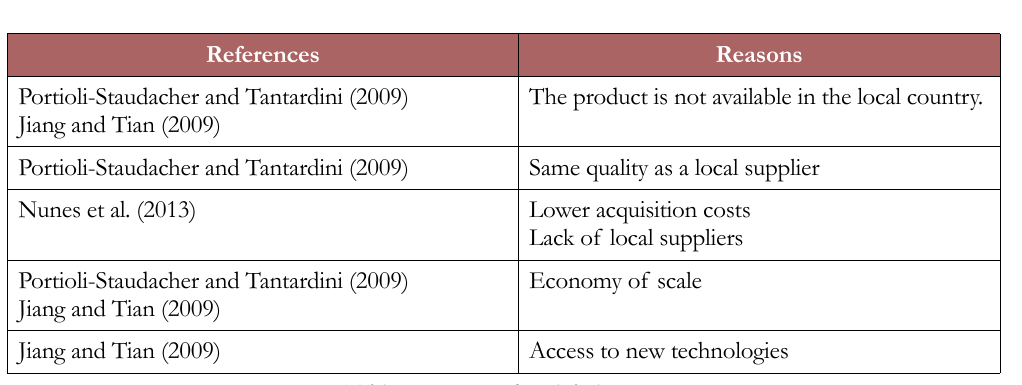
Table 1. Reasons for global